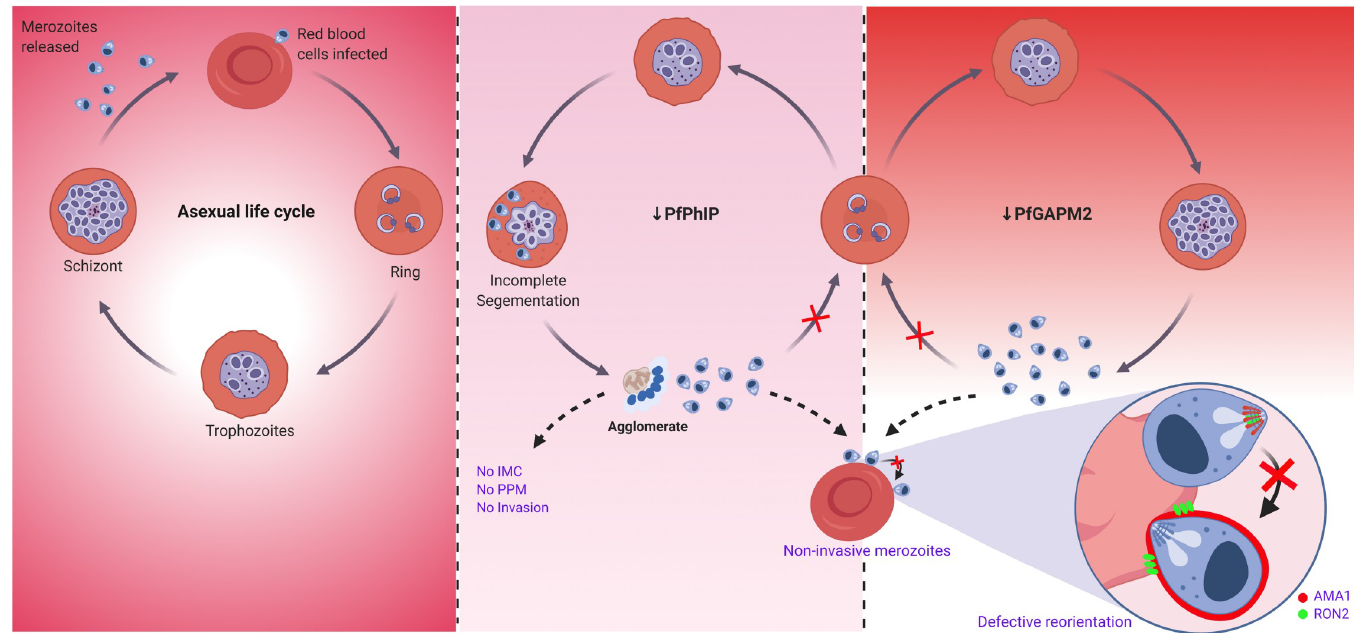
Fig 6. Function of PhIL1-associated complex is crucial for reorientation mediated by gliding motor complex and thus host-cell invasion by Plasmodium falciparum merozoites. The schematic illustrates GAPM2 and PhIP are essential for blood-stage infection and their genetic attenuation arrests merozoite invasion by impeding the function of glideosomal motor machinery resulting in failure of merozoite to reorient its apical end towards the host RBC. Depletion of PhIP also leads to the formation of agglomerates of unsegmented schizonts suggesting its probable role in IMC-mediated parasite cell division. In the left panel, the level of PfPhIP or GAPM2 protein is maintained by the absence of GlcN. The middle panel shows consequences of PhIP deficiency, wherein a portion of daughter cells get segmented while others remain trapped as an agglomerate under a common plasma membrane. In the agglomerate, IMC fails to form, parasite plasma membrane surrounds multinucleated unsegmented daughter cell, and microneme secretion is affected. Few segmented merozoites which egressed were seen arrested at the erythrocyte surface and are unable to invade. The right panel summarizes the effect of GAPM2 deficiency in the parasite where the merozoites fail to invade the erythrocytes due to the disability of these merozoites to align their apical end towards the host cell surface. Apical reorientation of merozoites is imperative for invasion so that the apical organelles are aligned to the erythrocyte membrane which leads to the discharge of apical organellar proteins followed by invasion. Created with BioRender.com.